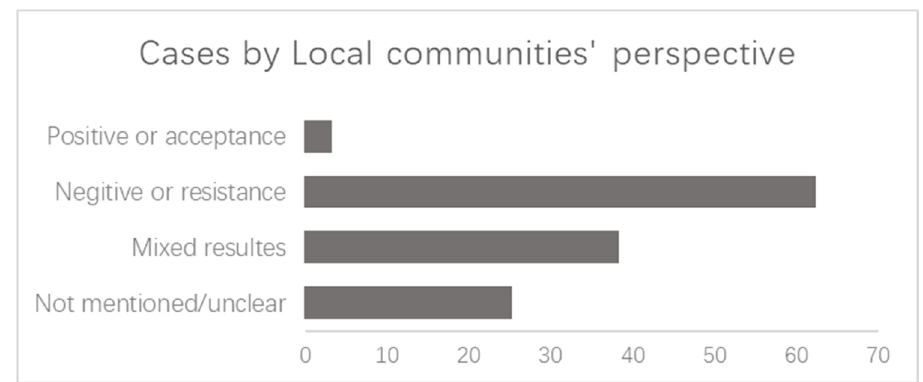
Figure 4. Cases by the perspective of the local community ( n =